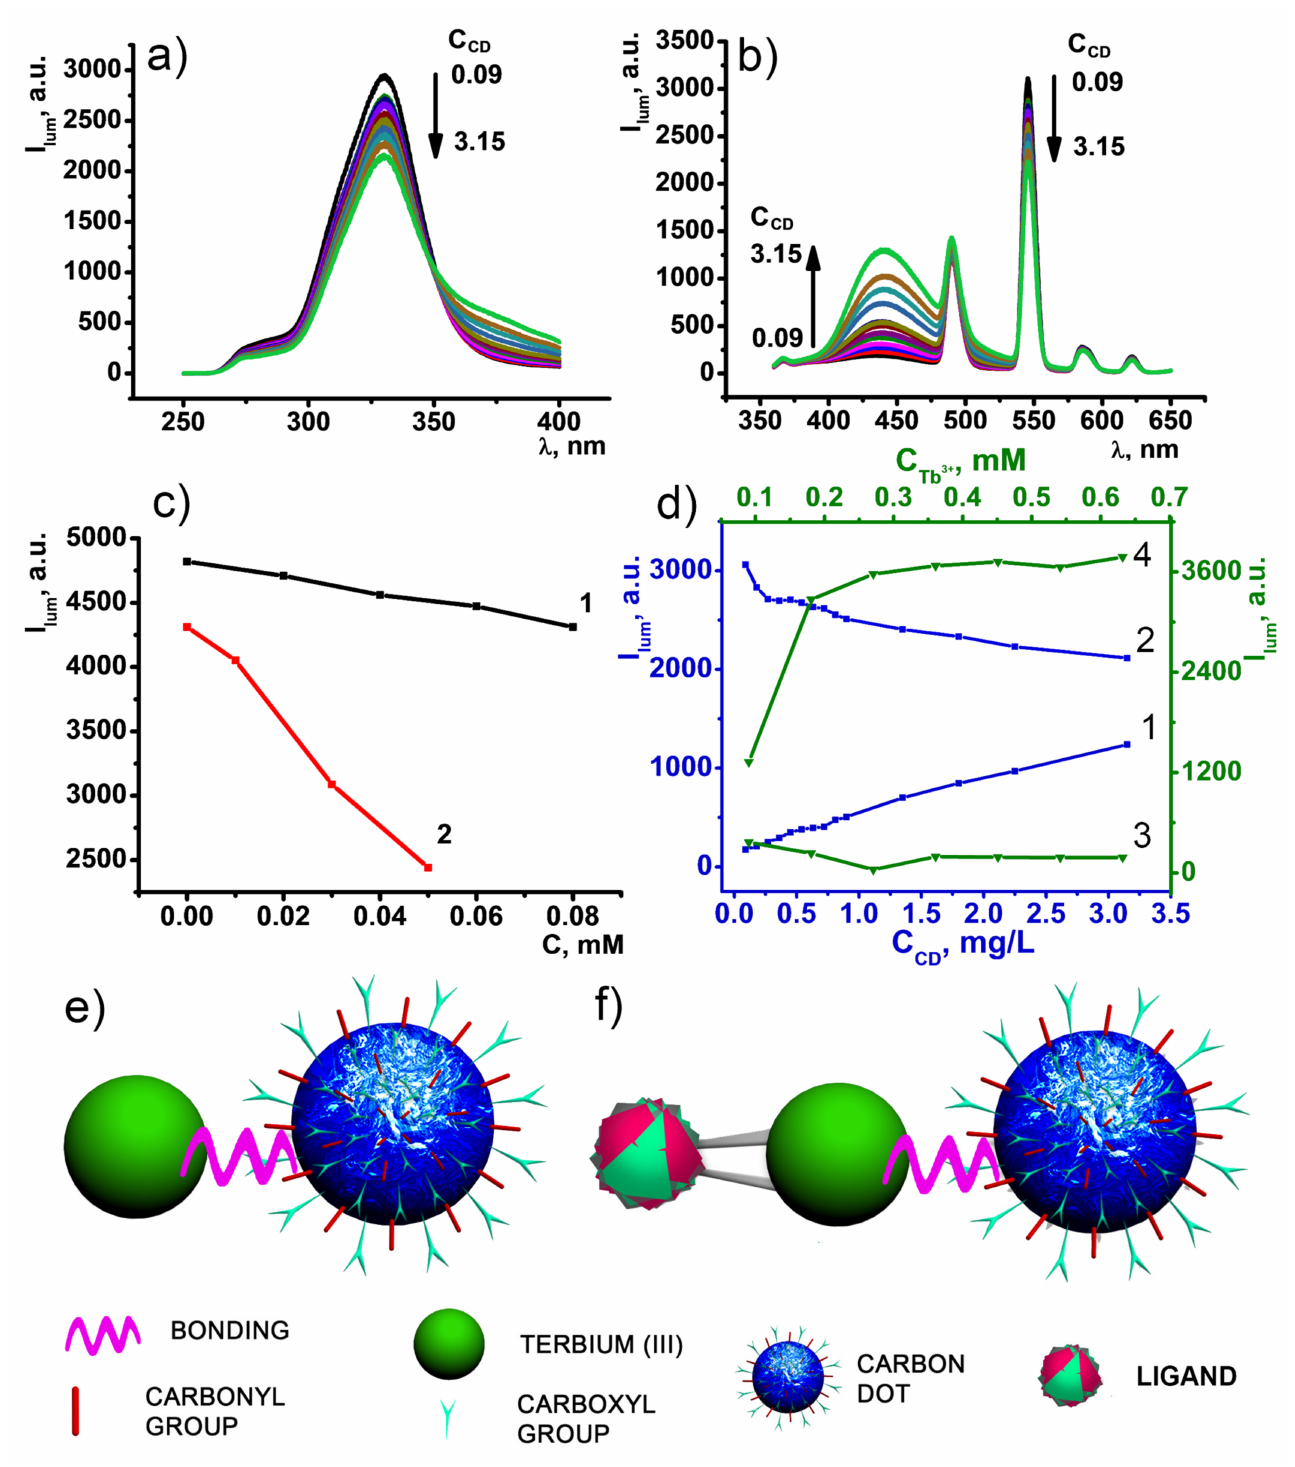
Figure 7. ( a ) Excitation ( λ em = 547 nm) and ( b ) emission ( λ ex = 330 nm) spectra of CDs and [TbL] + in DMF at different CDs to [TbL] + ratio (C CD = 0.09–3.15 mg · L − 1 ; C [TbL] = 0.45 mM). ( c ) Fluorescence intensity of CDs (0.01 g/L) versus C TEA (1) and versus C Tb (2) in the presence of 0.08 mM TEA in DMF. ( d ) Intensity of 450 nm (1) and 547 nm (2) emission peaks as a function of C CDs at constant C [TbL] = 0.45 mM. Intensity of 450 nm (3) and 547 nm (4) emission peaks as a function of C [TbL]+ at constant C CD = 4.5 mg · L − 1 in DMF. ( e ) Schematic view of Tb-L interaction exemplified by Equilibrium 1 . ( f ) Schematic view of CD-Tb-L interaction exemplified by Equilibrium 2